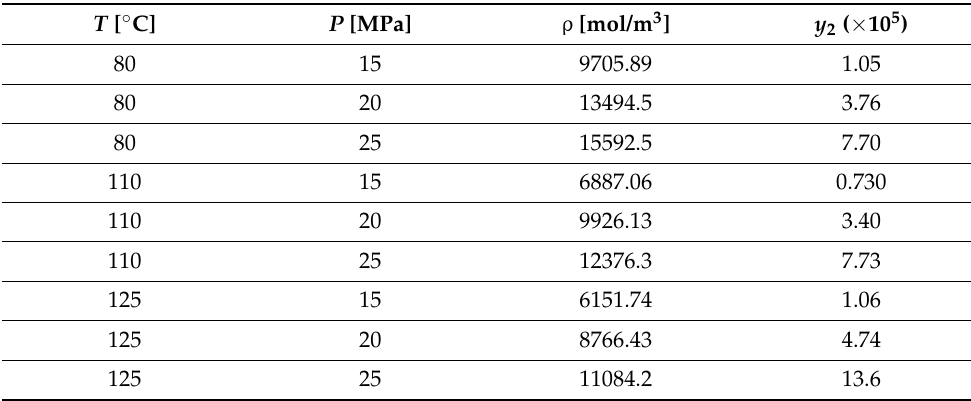
Table 1. Solubility of C.I. Disperse Red 22 in scCO 2 .